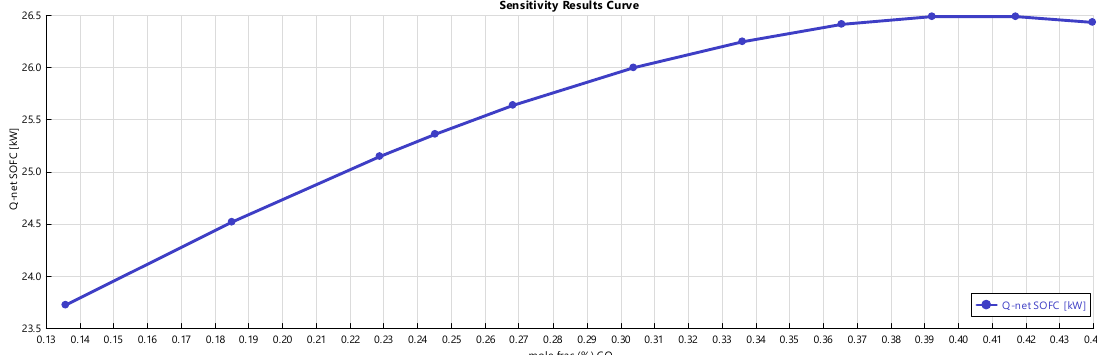
Figure 9. Influence of CO concentration on SOFC power production.